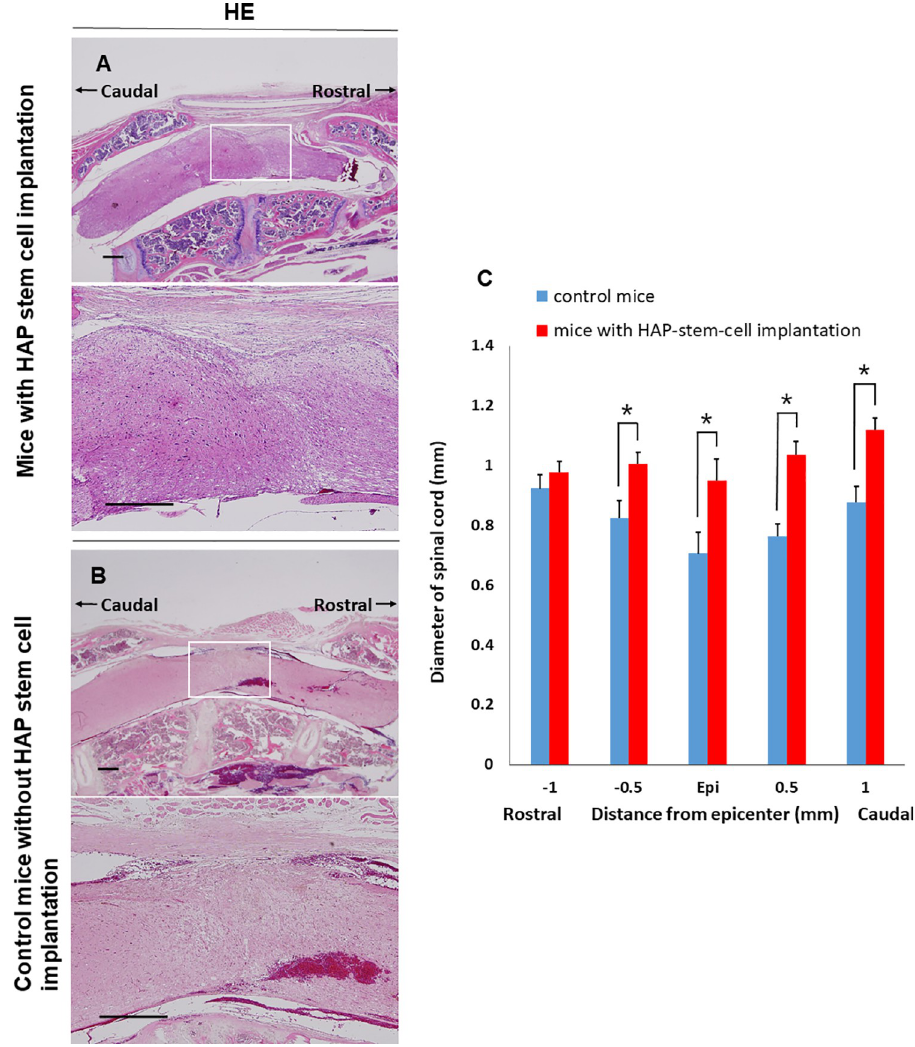
severed spinal cord. (C) Diameter of the severed spinal cord after HAP-stem-cell implantation (mice with HAP-stem- cell implantation: n = 5; control mice without implantation: n = 5). � P < 0.05. Upper panels = low-magnification. Bar = 500 μ m. Lower panels = high-magnification of white boxed area. Bar = 500 μ m. All images show sagittal sections with the spinal